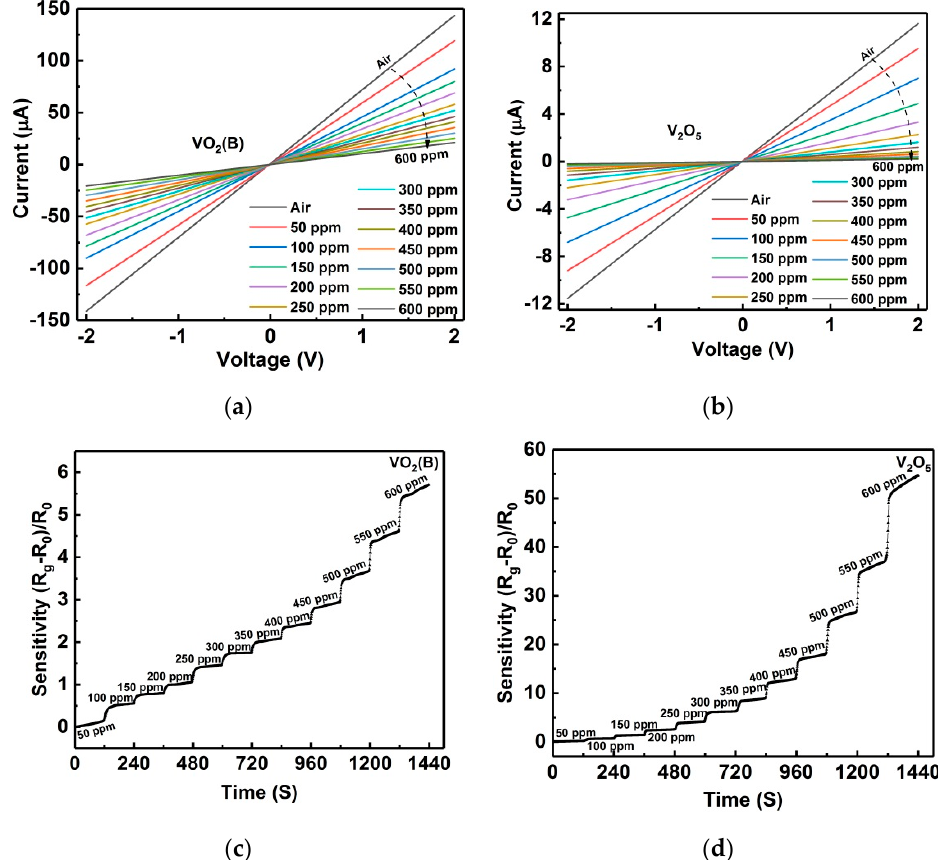
Figure 6. Room temperature I-V curves for sensors of ( a ) VO 2 (B), and ( b ) V 2 O 5 nanoflakes measured in different static ammonia atmosphere from 0 to 600 ppm. Sensor responses of ( c ) VO 2 (B) and ( d ) V 2 O 5 nanoflakes to ascending ammonia levels step-by-step.